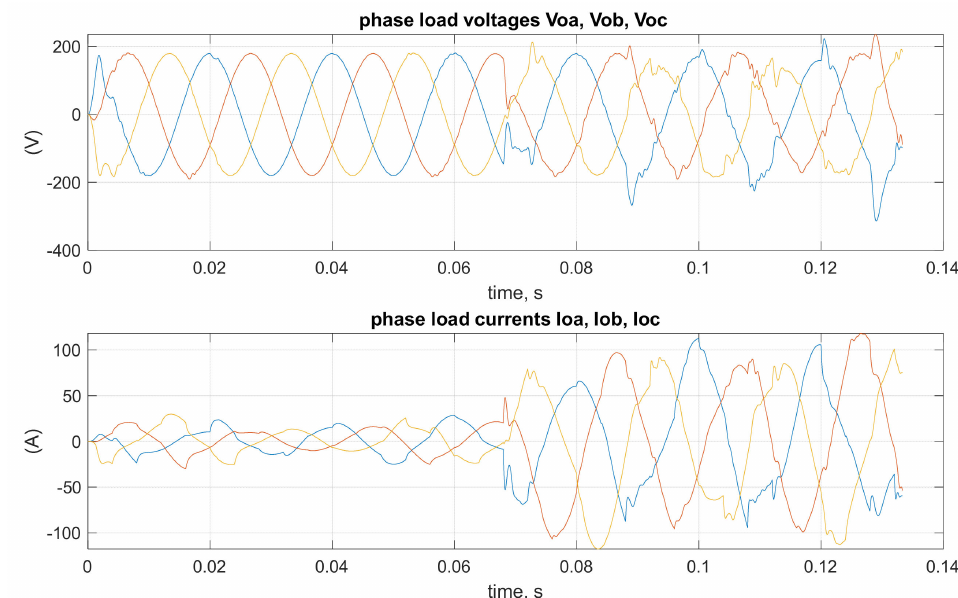
Figure 13. Waveforms of load voltage V o and the distorted load current I o in the dq coordinate system, with no limitations on the rotor current, limitations on rotor voltage V f _ m = 450 V and capacity C o = 100 µ F during steep increase of the system